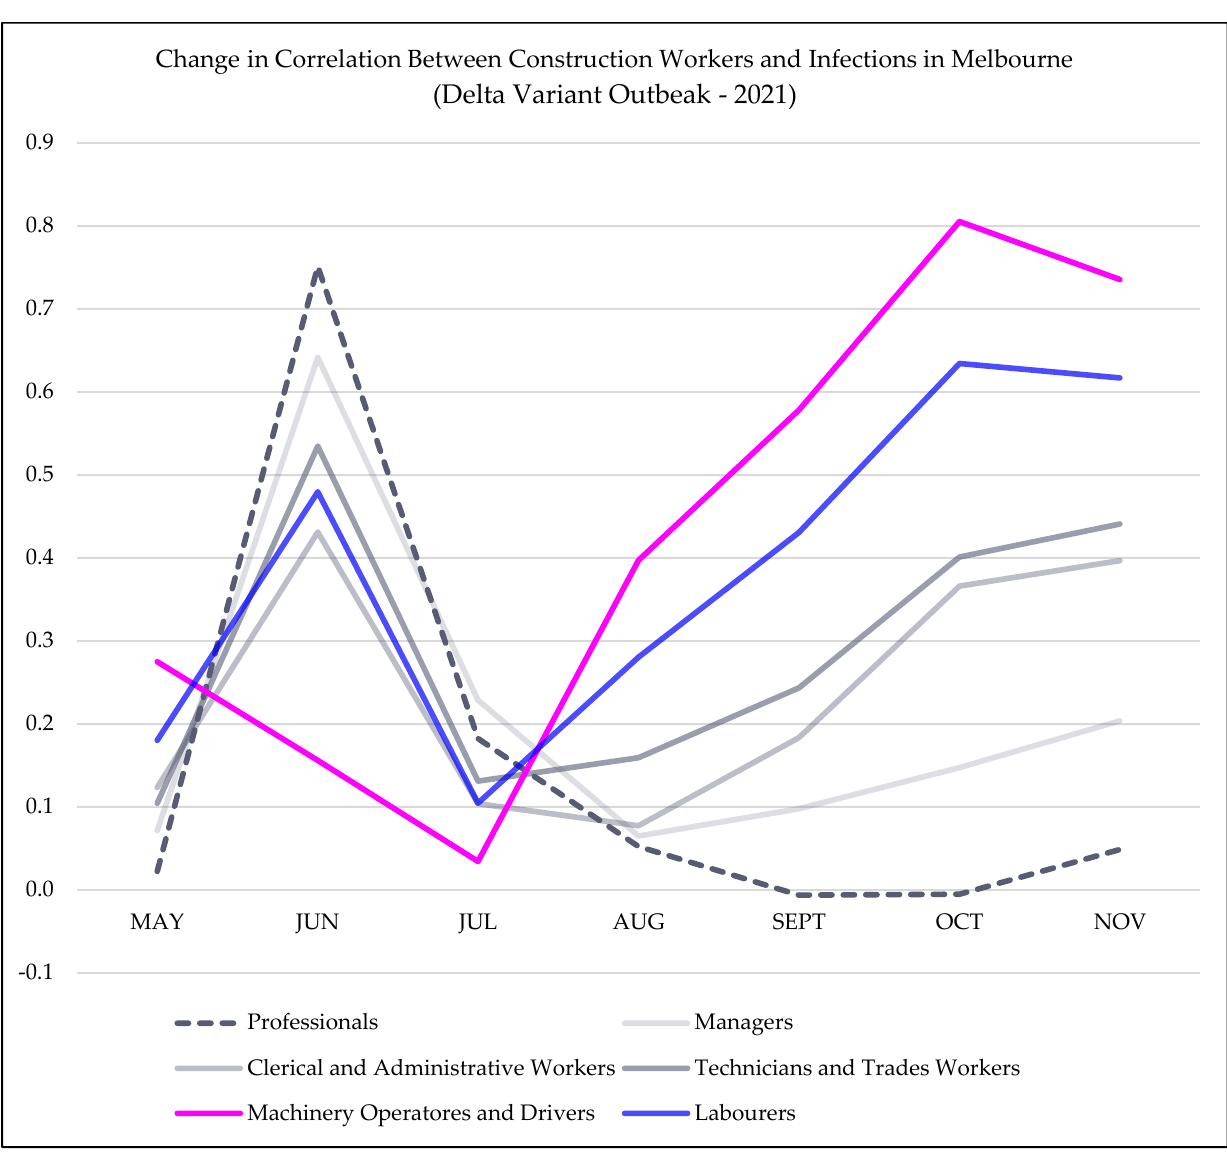
Figure 10. The changing risk profile of construction workers over the duration of the outbreak of the Delta Variant in Melbourne.